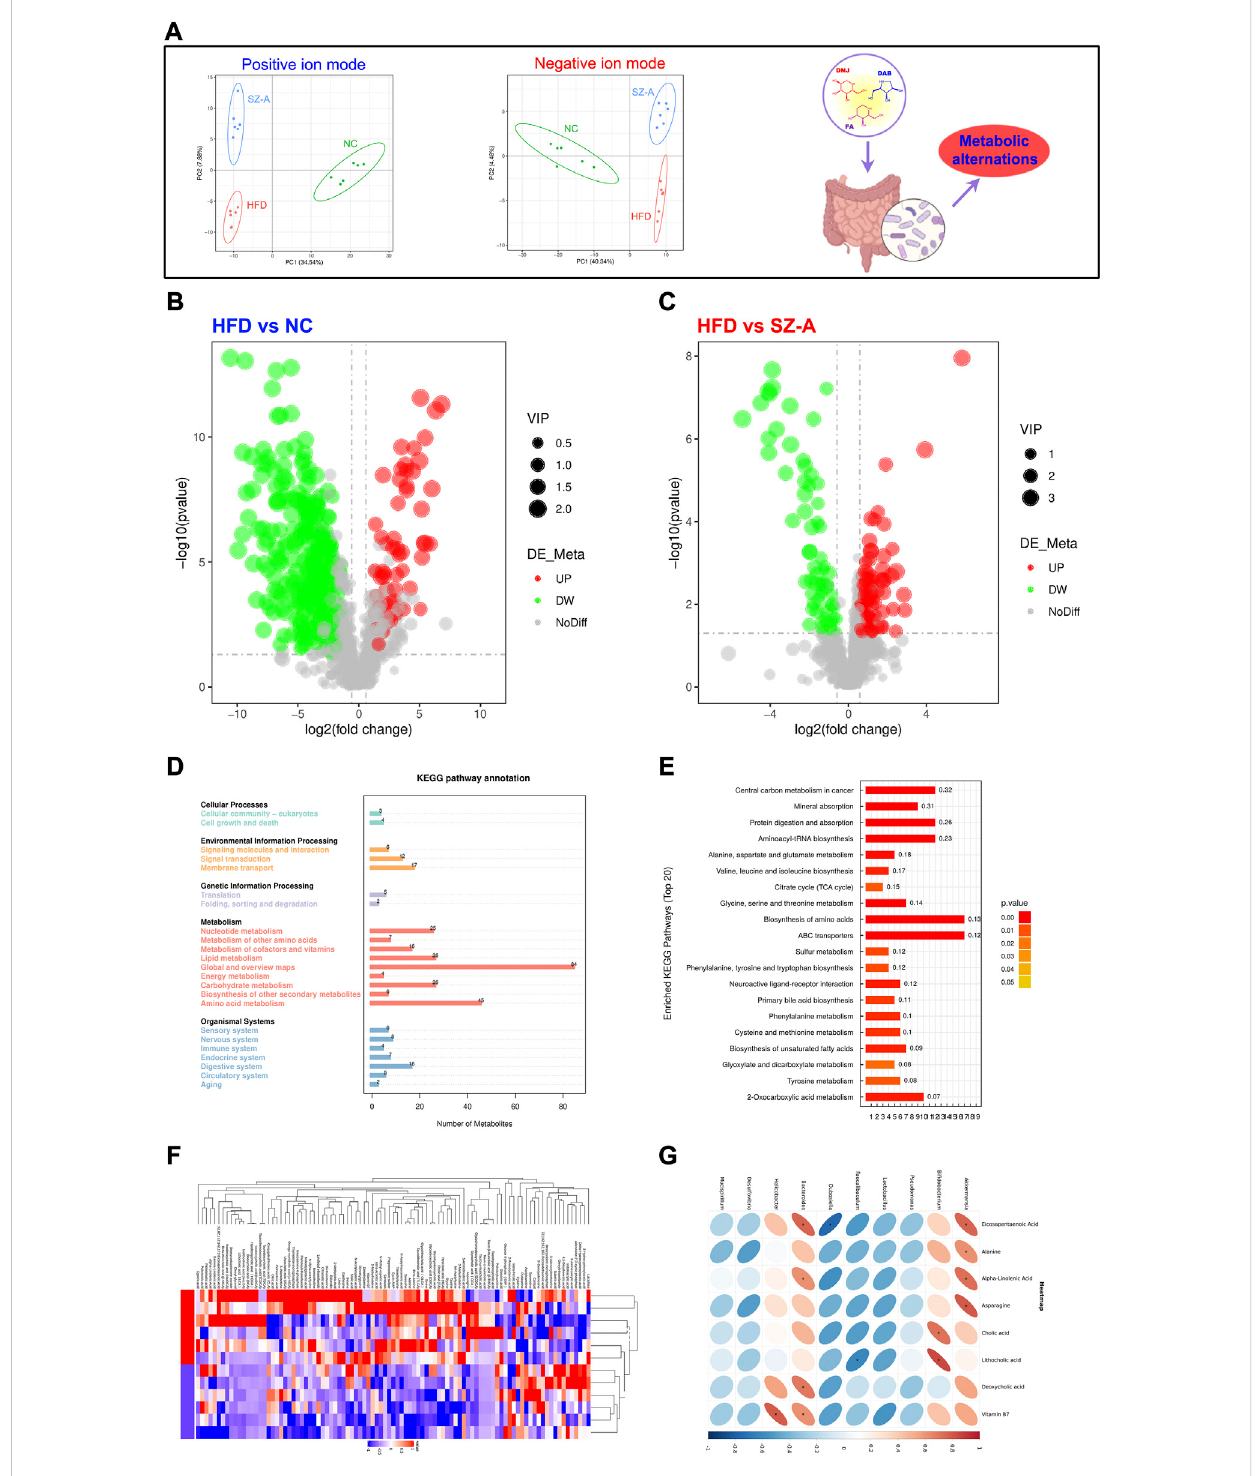
FIGURE 4 SZ-A regulated metabolic disorders in HFD-induced obese mice. (A) PLS-DA, Partial Least Squares Discrimination Analysis. (B, C) Volcano plot. (D) Kyoto Encyclopedia of Genes and Genomes (KEGG) path annotation. (E) KEGG enrichment pathway. (F) Heat map. (G) The correlation analysis between gut microbiota and host metabolites after the SZ-A